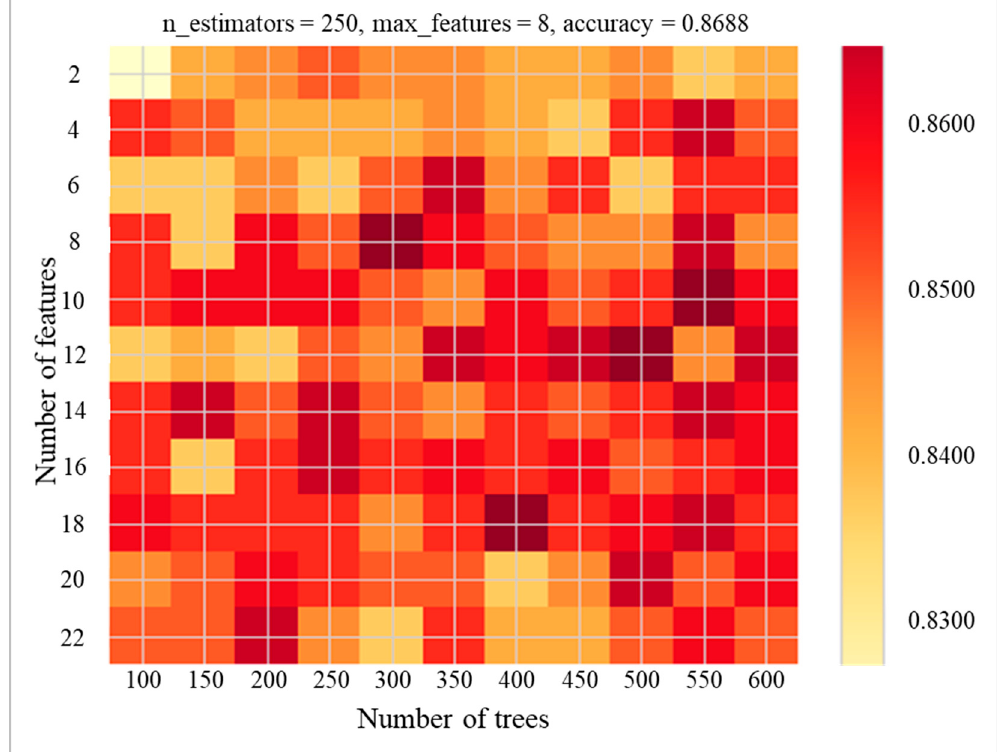
Figure 5. Value range of ntree and mtry, and the accuracy of different combinations of ntree and mtry. Darker colors represent higher accuracies. ntree represents number of trees and mtry represents the number of features.